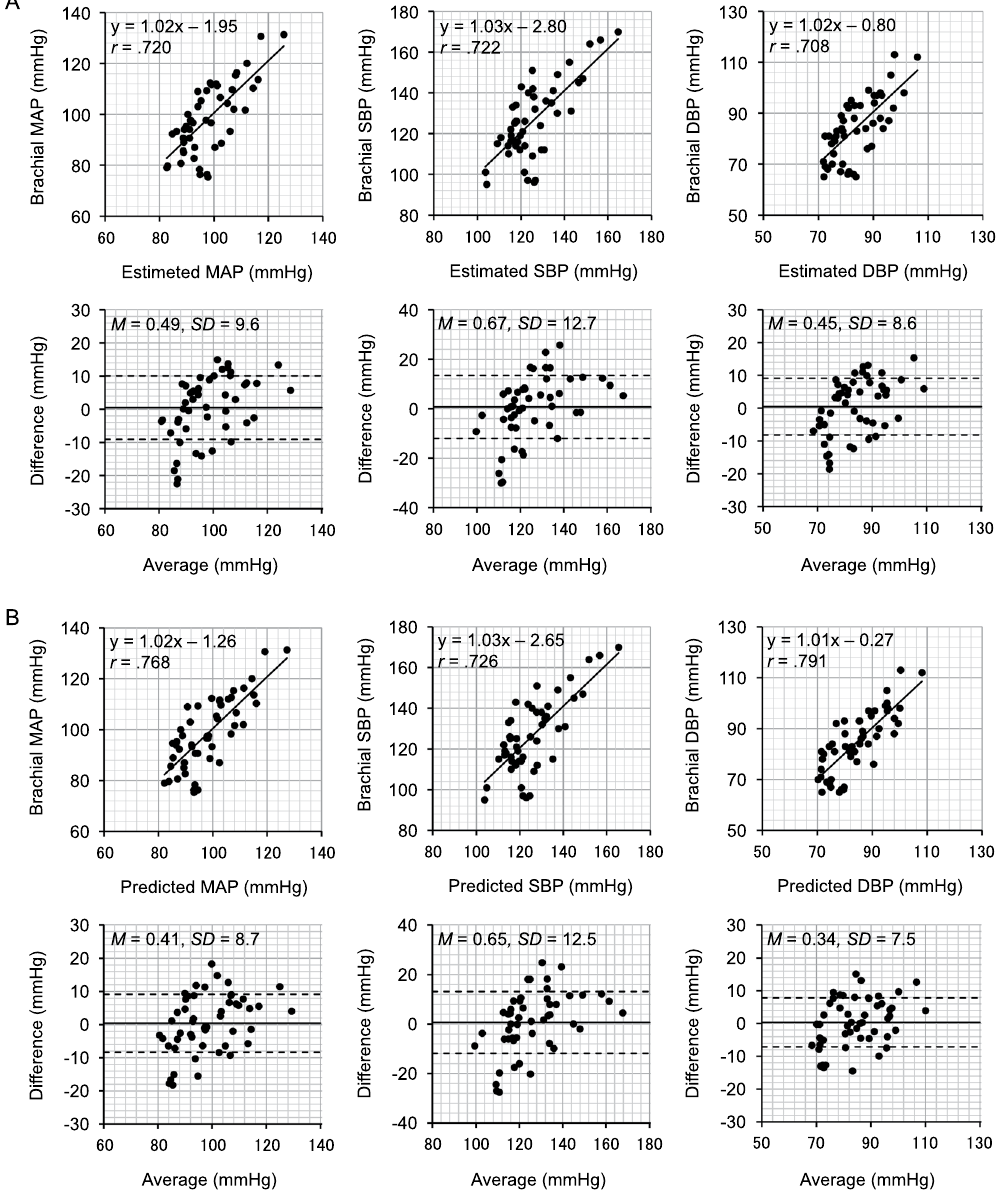
Figure 2. The accuracy of blood pressure estimation attained by the proposed method. ( A ) Scatterplots of mean arterial pressure (MAP: Left), systolic blood pressure (SBP: Middle), and diastolic blood pressure (DBP: Right) estimated using only the smartphone and measured using a brachial cuff sphygmomanometer ( N = 49). (Upper) Solid line represents the regression line and its formula, together with r value, is shown in each scatterplot. (Lower) Corresponding Bland–Altman plots. Solid line and dashed lines represent fixed bias ( M ) and M ± 1 standard deviation ( SD ) range, respectively. Average = (estimate + brachial)/2, Difference = brachial – estimate. ( B ) The same analyses of (A) but using data from the dedicated photoplethysmograph ( N =